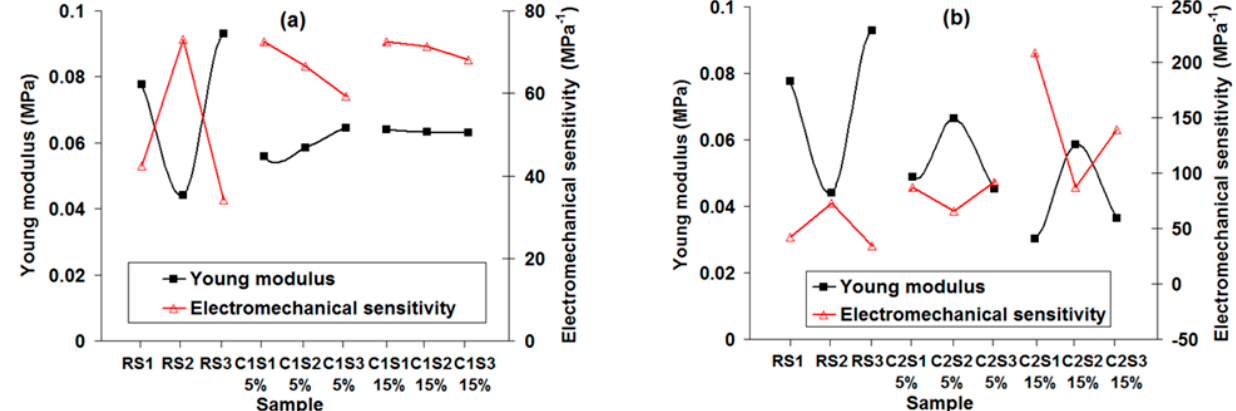
Figure 3. Electromechanical sensitivity of the samples compared with the Young’s modulus values: ( a ) samples with complex C1; ( b ) samples with complex C2.